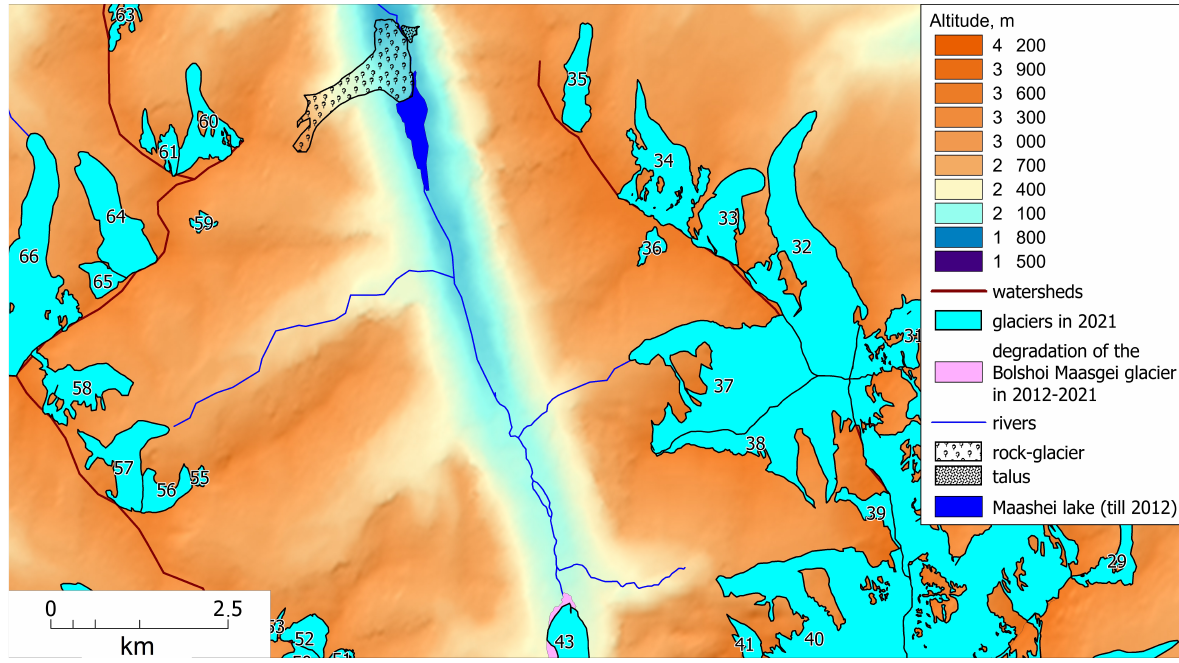
Figure 19. The position of Lake Maashei relative to the edge of the Bolshoi Maashei glacier (No.